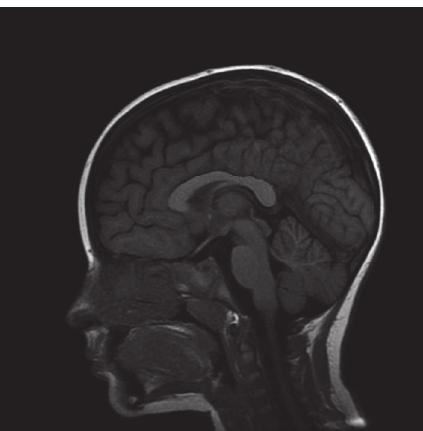
Figure 1: Brain MRI. Sagittal T1-weighted image demonstrating intact corpus